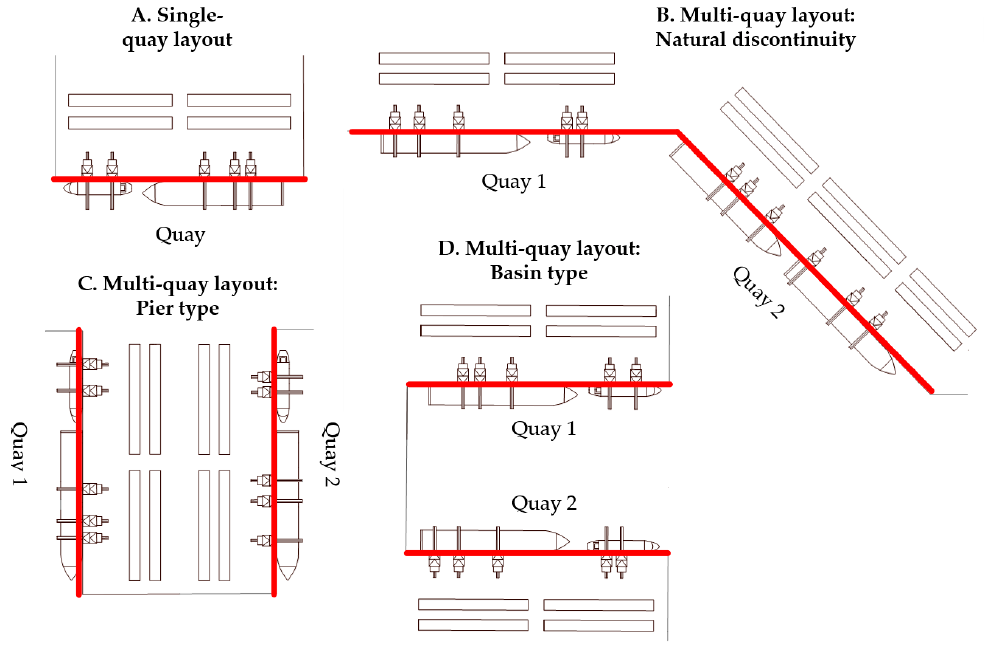
ff erent layouts for multi-quay container Figure 1. Different layouts for multi-quay container terminals. Figure 1. Di